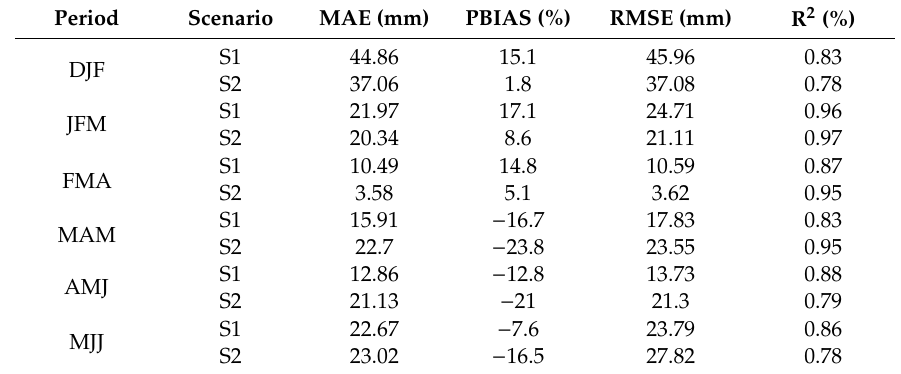
Table 7. Statistical and e ffi ciency indicators for the evaluation of prognostic performance in R3.